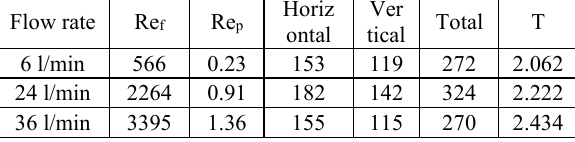
Table 3. Results of the measurement and statistical analysis in the straight tube equipped with the bifurcation (the measurement was performed upstream of the bifurcation).